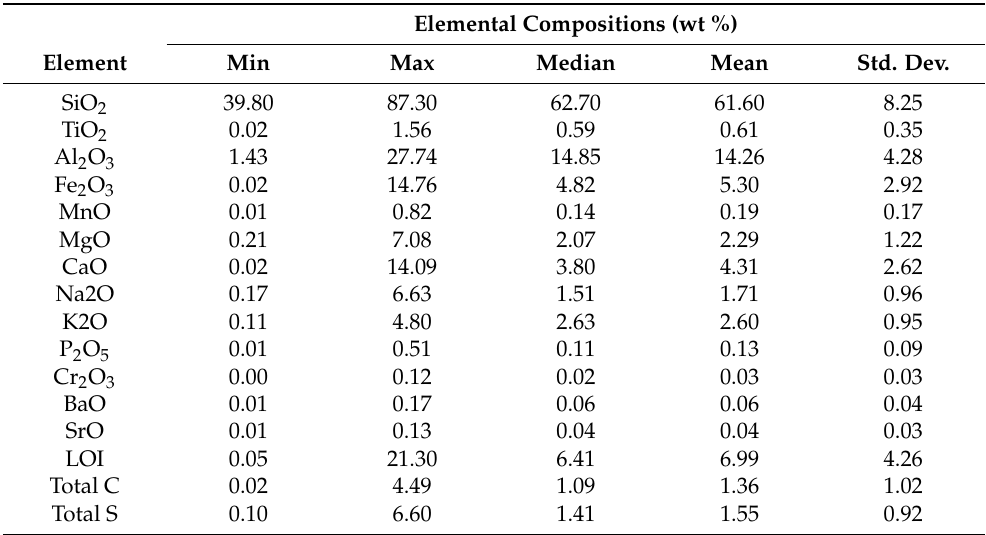
Table A1. Summary of descriptive statistics for major elemental compositions in 750 samples.